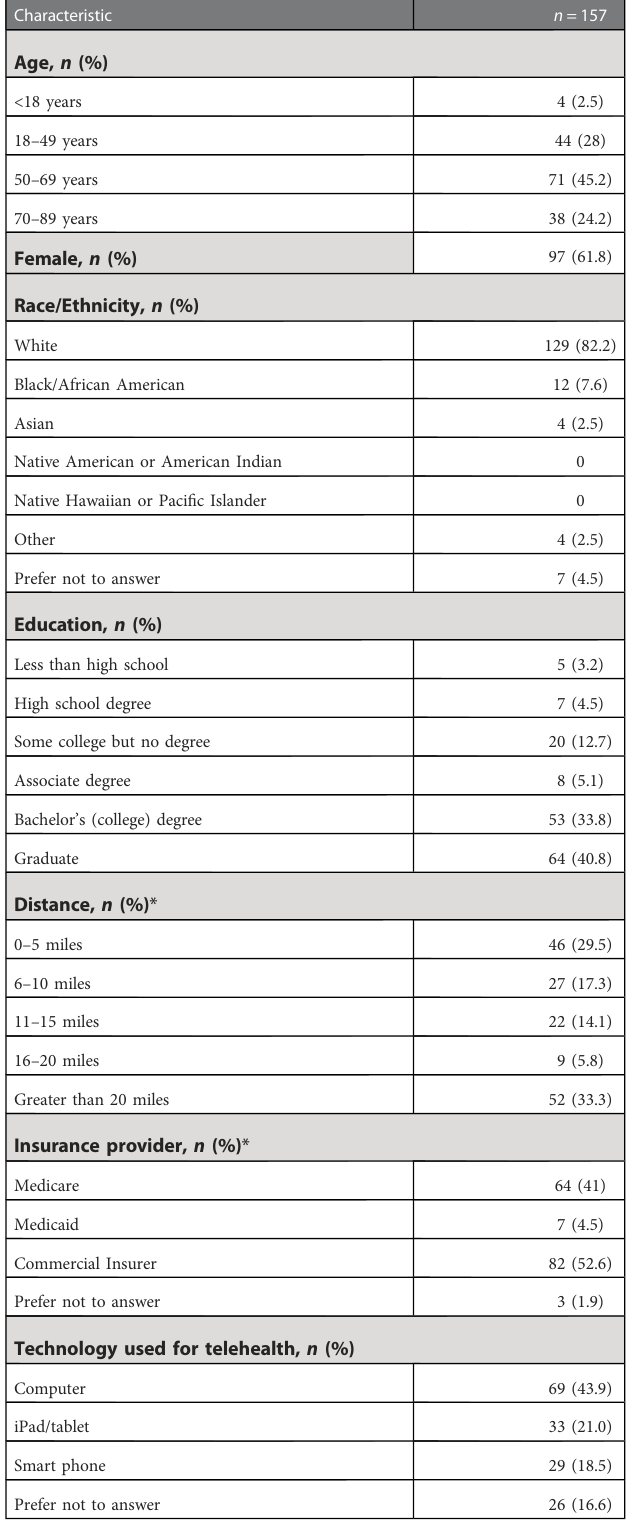
TABLE 1 Sample characteristics by telehealth